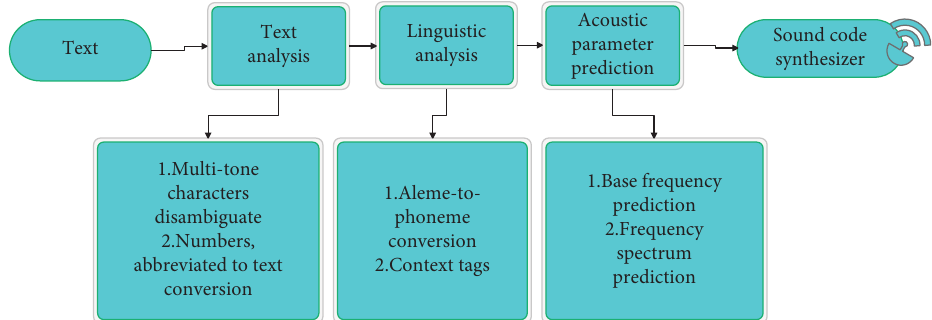
Figure 1: Statistical parametric speech synthesis model based on hidden Markov chain.